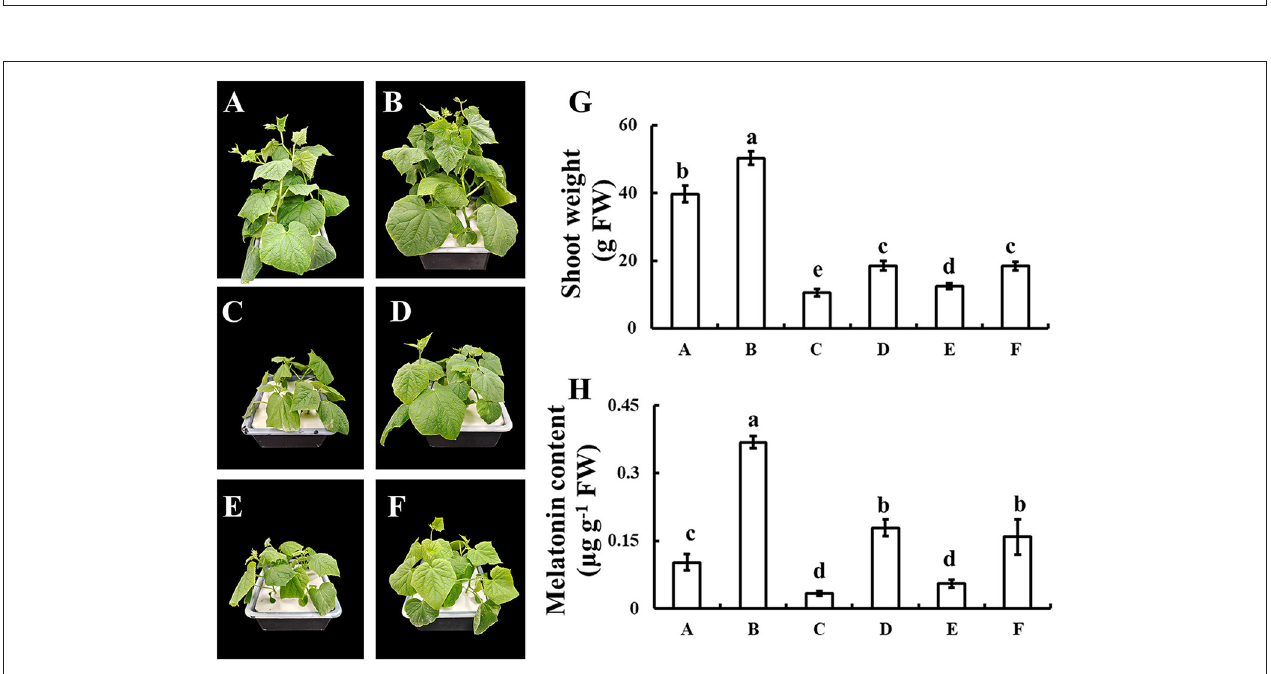
FIGURE 4 | Effects of exogenous selenium on endogenous melatonin. (A–D) The phenotype of control, selenium application, cold stress, and selenium application under cold stress condition. (E) The phenotype of selenium and melatonin biosynthesis inhibitor application under cold stress condition. (F) The phenotype of selenium, melatonin, and melatonin biosynthesis inhibitor application under cold stress condition. (G) Shoot weight of A-F. (H) Melatonin content of A-F. Values are expressed as means of three replicates ± SD, and different letters are significantly different ( P < 0.05).